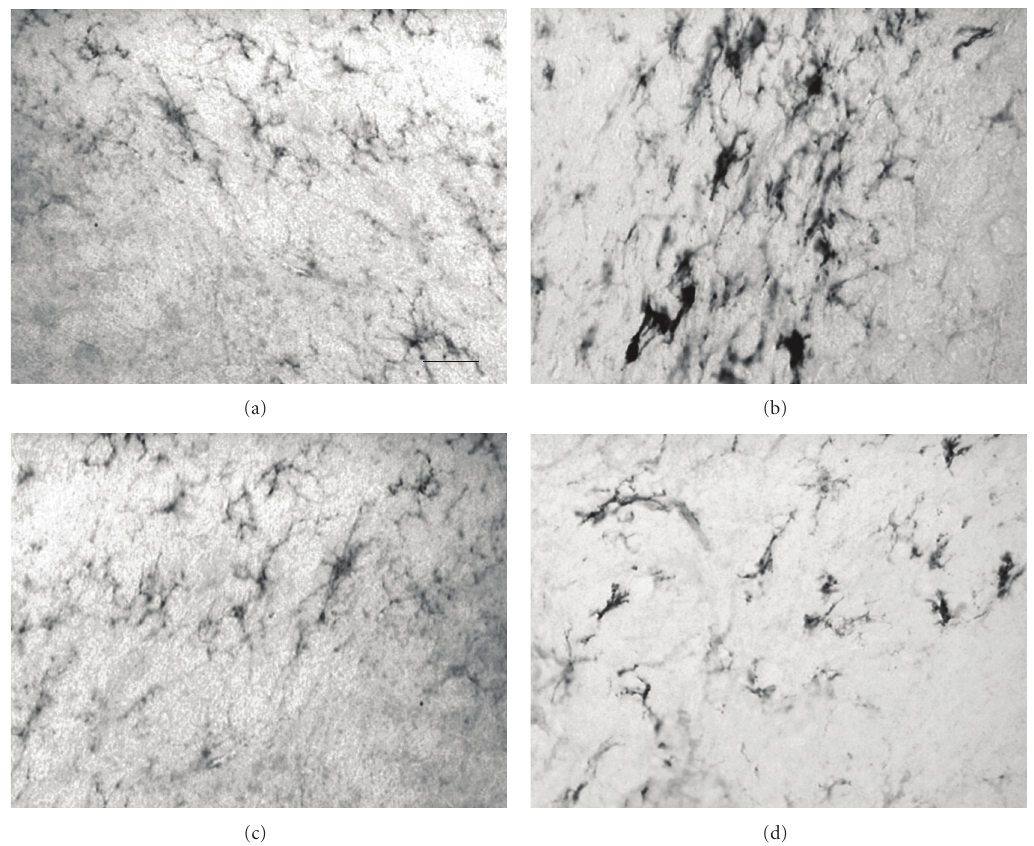
Figure 4: Neuroprotection against 6-OHDA toxicity following delayed subchronic intranigral administration of 2 R ,4 R -APDC is associated with reduced numbers of activated microglia in the SNc. Representative photomicrographs ( × 40) of DAB/peroxidase staining for OX-6, a marker of activated microglia in the SNc from each treatment group (scale bar 200 μ m.). (a) 6-OHDA + vehicle, unlesioned SNc,